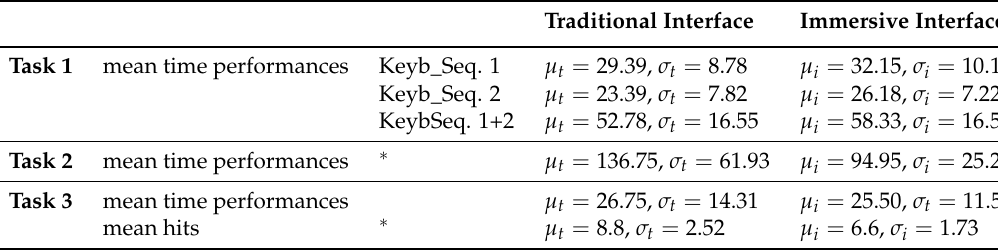
Figure 9. Task 3: ( a ) mean task-time performance to follow a 3D path with a metallic loop avoiding contact with the guiding pipe; ( b ) mean hits. Table 3. Mean performance measures summary of Tasks 1, 2, and 3.